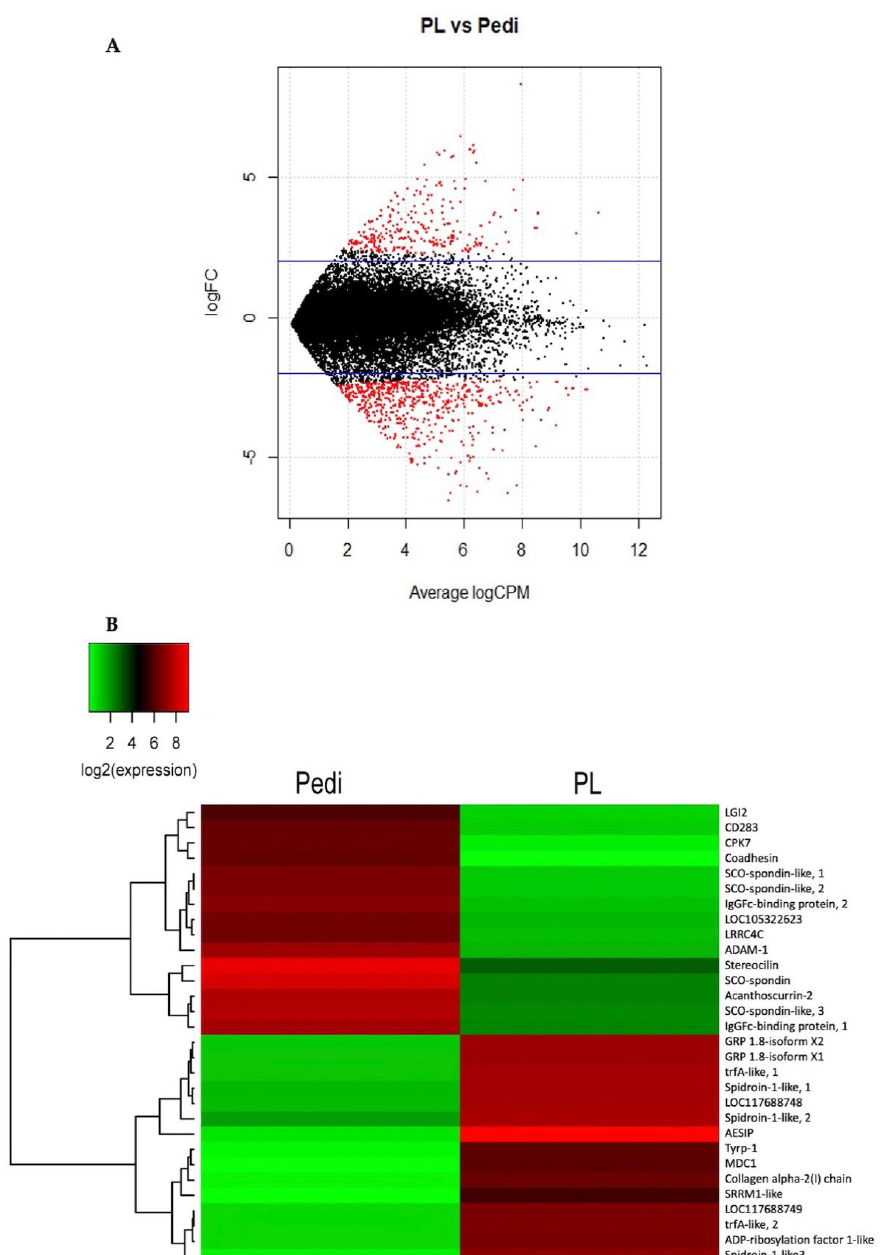
Figure 2. MA plot of transcripts with differential expression in Crassostrea gigas after settlement induction by a conspecific cue ( A ) and heat map expression pattern of the top thirty transcripts with differential expression ( B ). ( A ) Blue lines indicate transcripts that were filtered with a threshold value set at FDR < 0.01. The red dots indicate those transcripts that were considered as differentially expressed and met the two filtration threshold criteria: log-fold of change (logFC) ≥ 2 and FDR < 0.01. Red dots shown with a positive and negative logFC denote transcripts that were upregulated and downregulated, respectively, after settlement induction. Abbreviation: Average log CPM = log count-per-million; ( B ) The list of the top thirty transcripts with differential expressions were those that showed the highest logFC and lowest FDR values. The color intensity from green to red indicates low to highest logFC of expression in Pedi and PL batches. Transcripts with similar expression levels were clustered as shown in the tree on the left of Figure 2. The unabbreviated names of the transcripts in this heat map are provided in Table